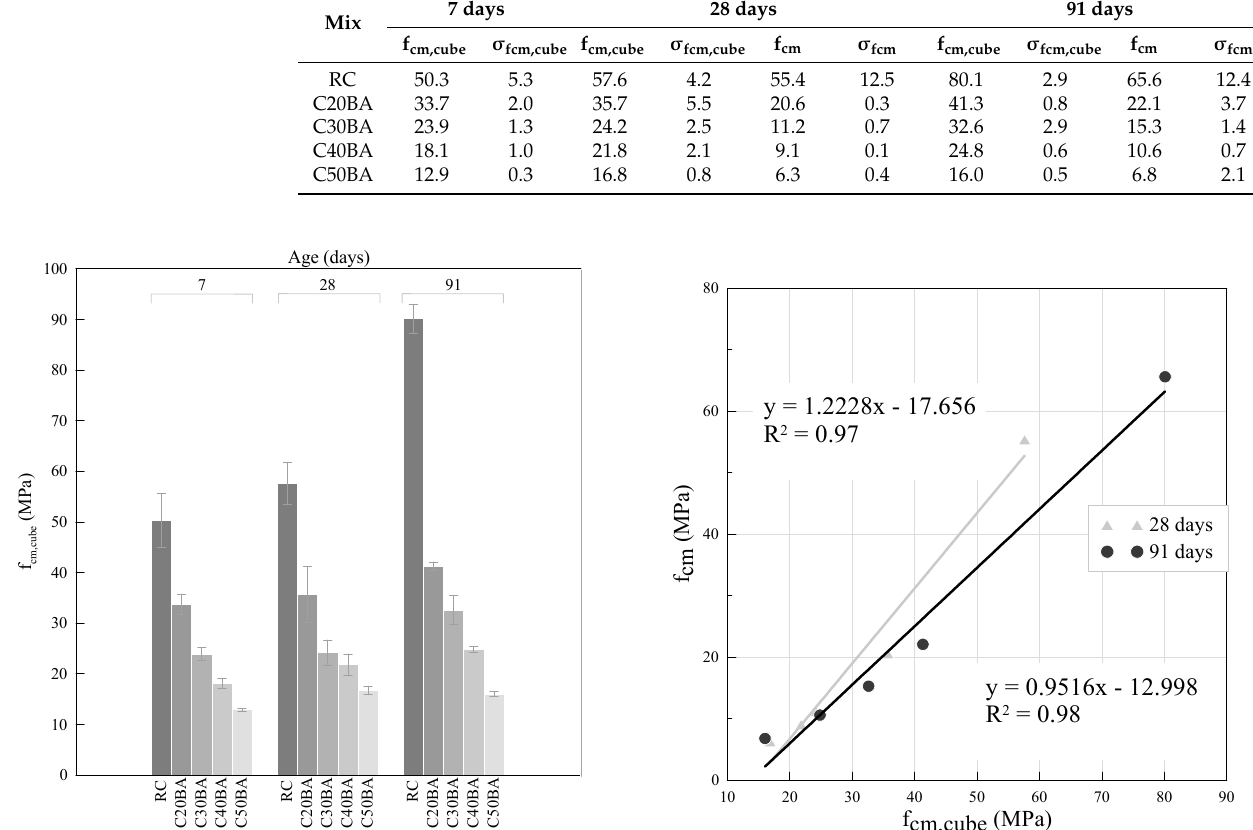
Table 6. Splitting tensile strength versus compressive strength determined according to EC2 at 28 and 91 days.